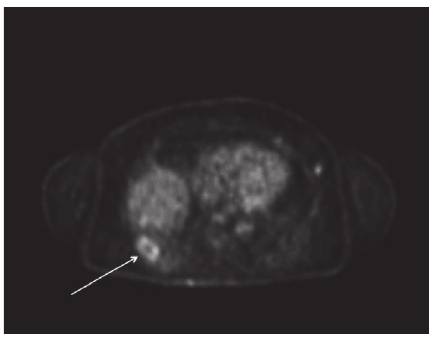
Figure2:PETscanidentifiescostophreniclungmassasperipherally hypermetabolic with relatively ametabolic central region, likely cavitation from necrosis (max SUV 3.9).